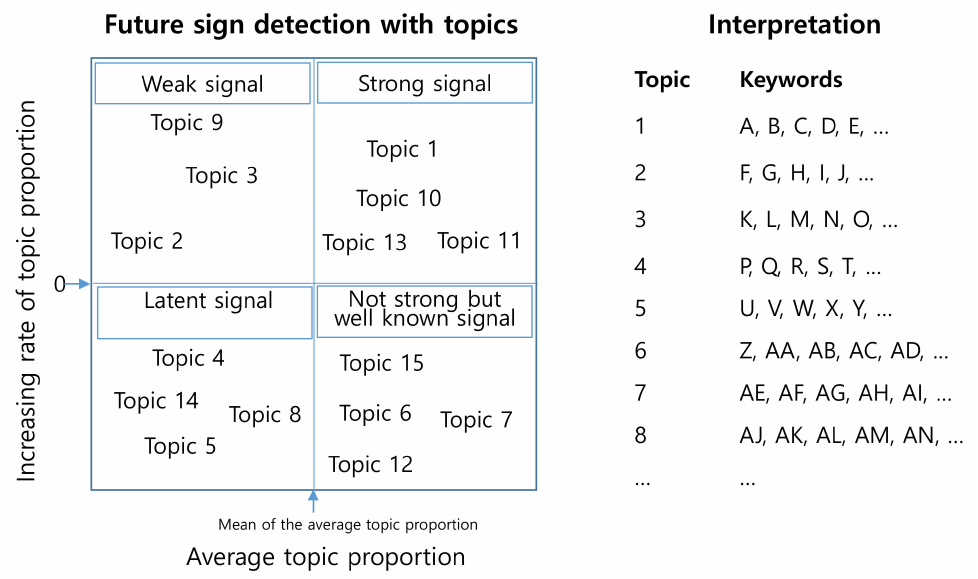
Figure 1. New process identifying future signs by using STM